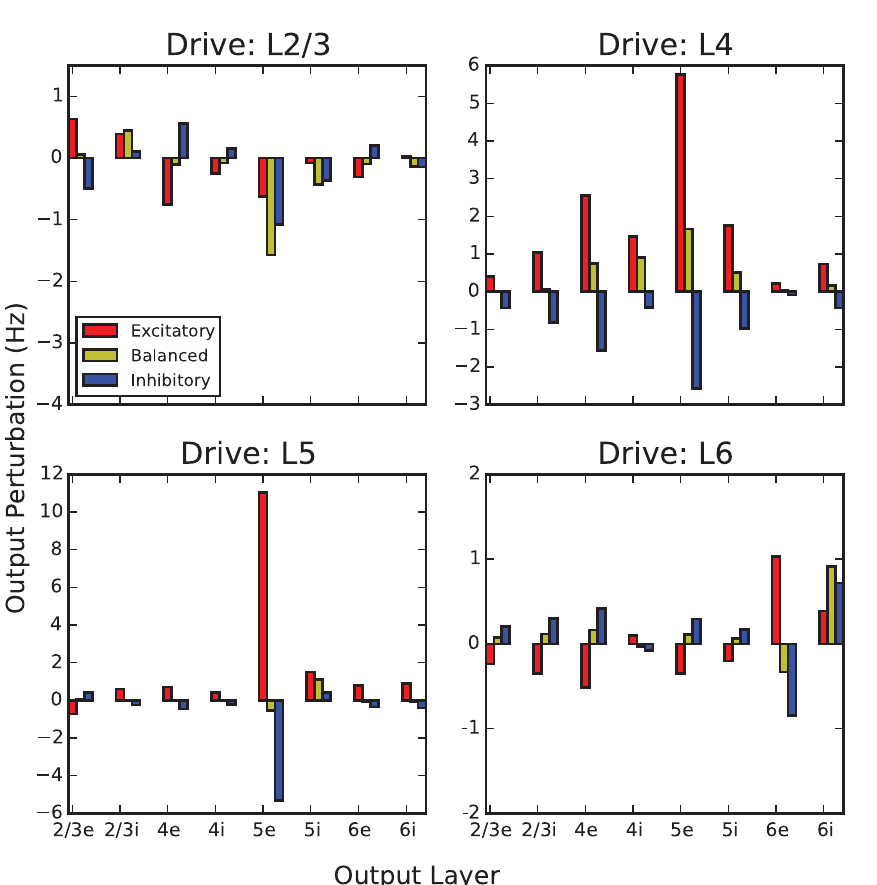
Fig 3. Summary of output perturbations evoked by single-layer step inputs. Step inputs are projected into a drive layer (L2/3, L4, L5, L6) under 3 different target specificity conditions. In all cases a 20 Hz firing rate input in excess of background excitation is applied at 100 ms, and output perturbation is defined as the difference between the eventual perturbed steady-state (200 ms) and the steady-state before perturbation. For example, balanced L2/3 drive (yellow, top-left panel) evokes an approximately 1.5 Hz decrease in firing rate in the L5e subpopulation, while balanced L4 drive (yellow, top-right panel) evokes a 1.5 Hz